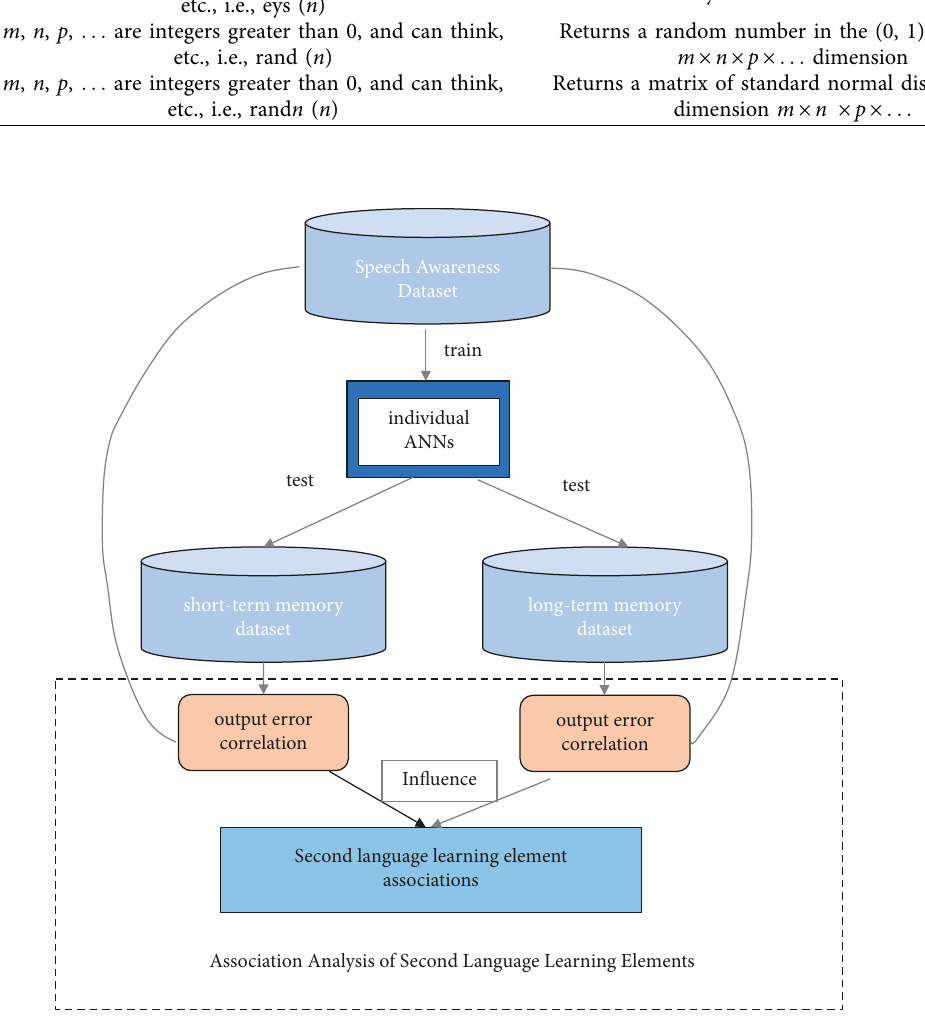
Figure 3: Hypothetical model of the association between phonological awareness and memory